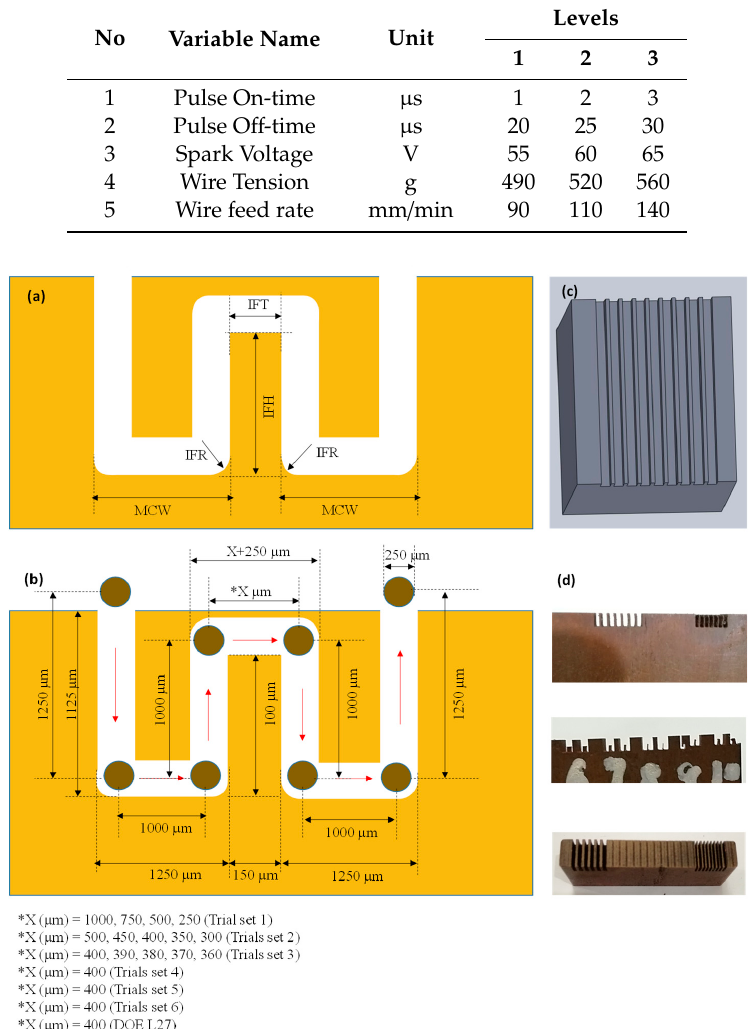
Table 2. Wire electrical discharge machining (WEDM) parameters utilized during micro-channels screening.